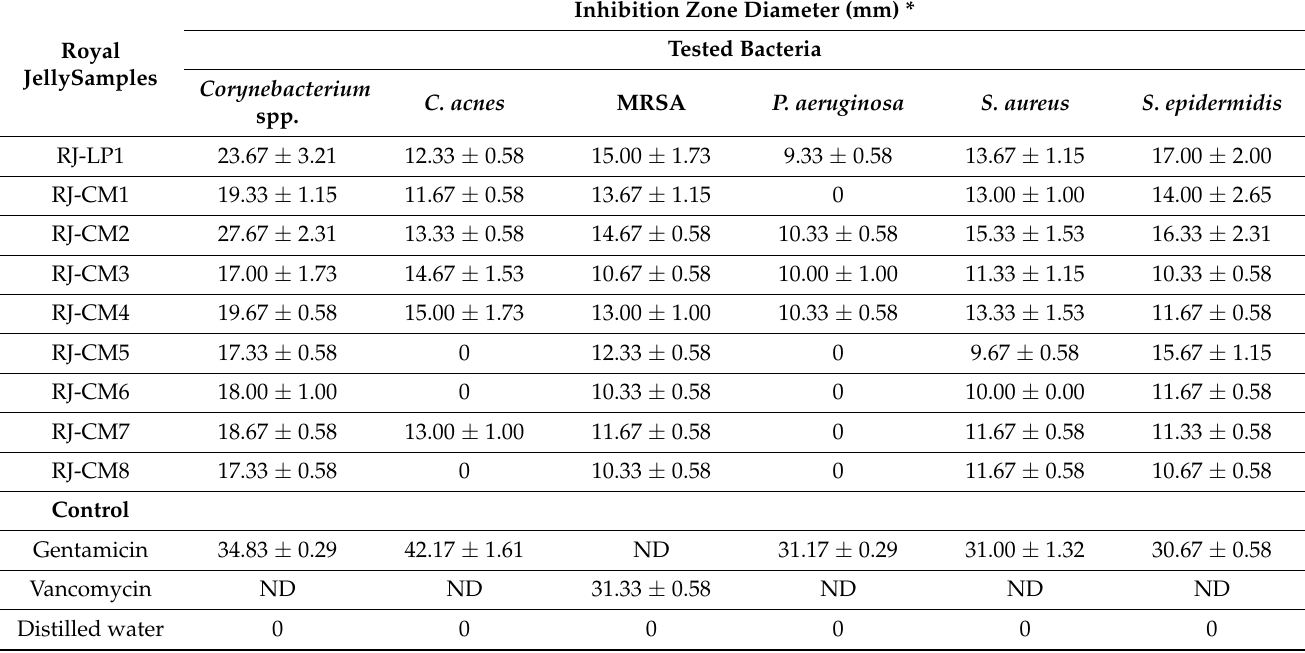
Table 1. Antibacterial activity of royal jelly samples against skin pathogenic bacteria by an agar well diffusion